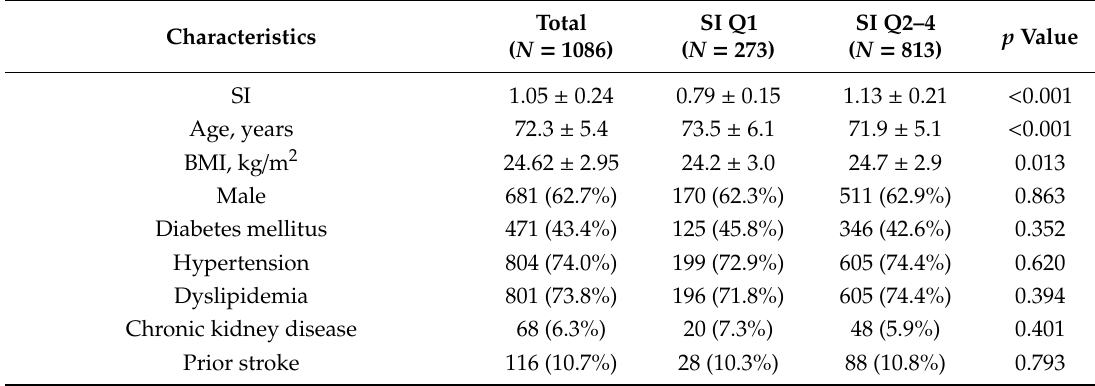
Table 1. Baseline clinical characteristics of subjects with the lowest quartile (Quartile 1) and upper quartiles (Quartile 2–4) of the